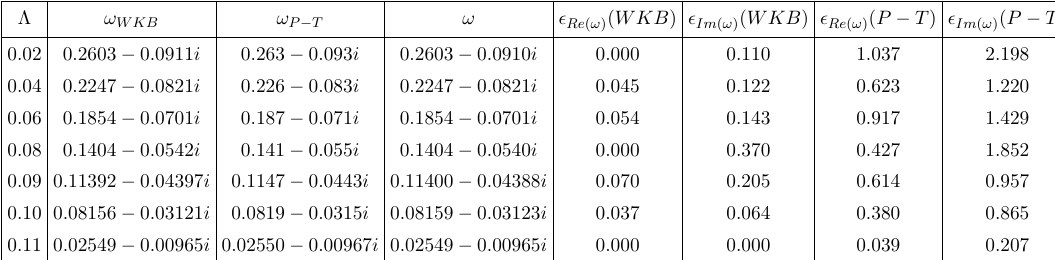
Table 1 . Dominant photon sphere modes ( n PS = 0) for massless scalar (cid:12)elds with ‘ = 1 in the background of Schwarzchild-de Sitter black holes. The values of ! WKB and ! P (cid:0) T appear in ref. [35].